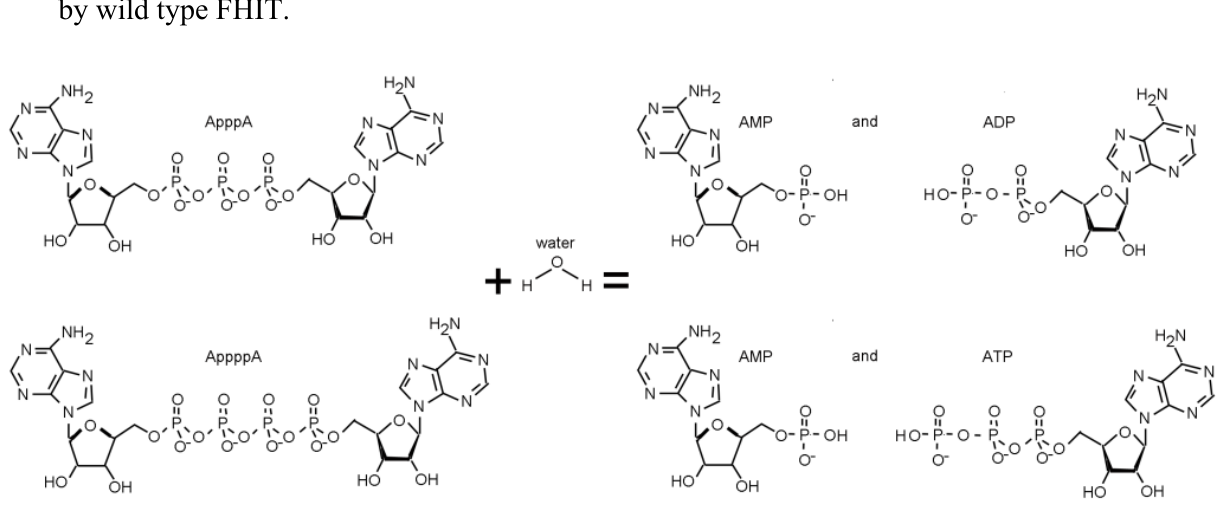
Figure 2. The FHIT substrates and hydrolysis reaction. Diadenosine triphosphate and diadenosine tetraphosphate are hydrolyzed to AMP + ADP and AMP + ATP, respectively, by wild type